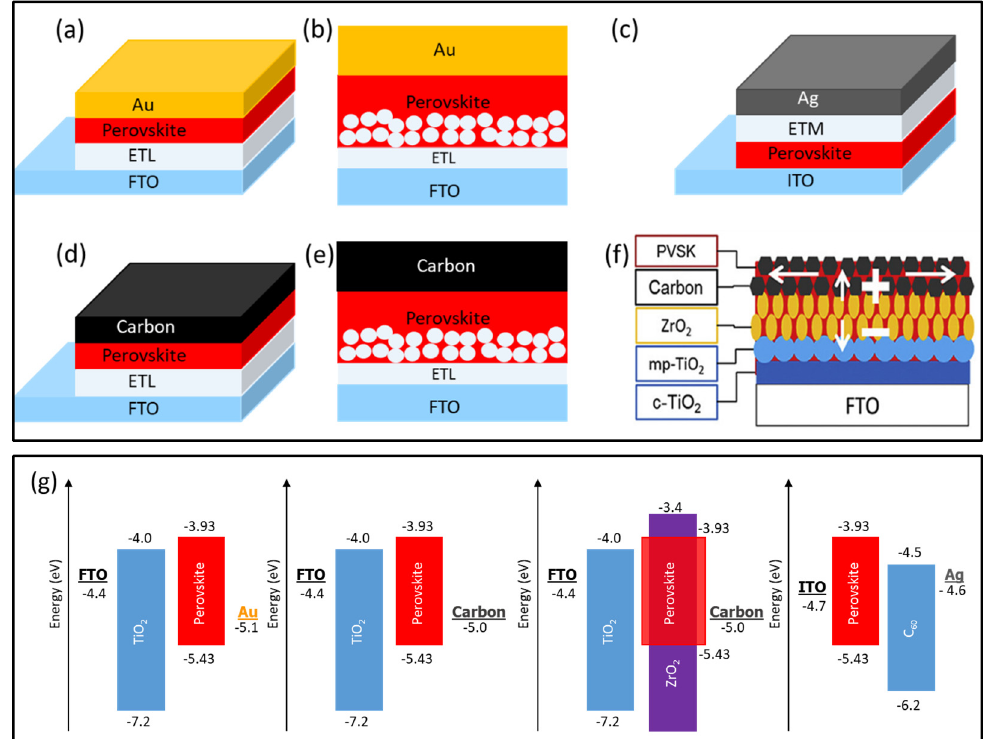
Figure 2. Schematic illustration of commonly employed HTM-free perovskite solar cell structures: ( a ) Planar architecture with Au as the back electrode; ( b ) mesoporous architecture with Au as back contact; ( c ) planar configuration with Ag as the rear electrode; ( d ) planar architecture with carbon as back contact; ( e ) mesoporous structure with carbon as back contact; and ( f ) monolithic device with carbon as the counter electrode. Reproduced with permission from [45]. Elsevier, 2018. ( g ) Schematic illustration of energy band diagrams of p-i-n and n-i-p HTM-free PSC structures with different counter electrodes. The key difference between mesoporous and monolithic carbon-based architectures is the perovskite deposition technique. In monolithic structure, the perovskite is infiltrated into the device after the deposition of all layers (see Figure 3c), whereas the perovskite layer is deposited over the mesoporous TiO 2 layer before the carbon layer in the mesoporous architecture (there is no spacer layer in this design).